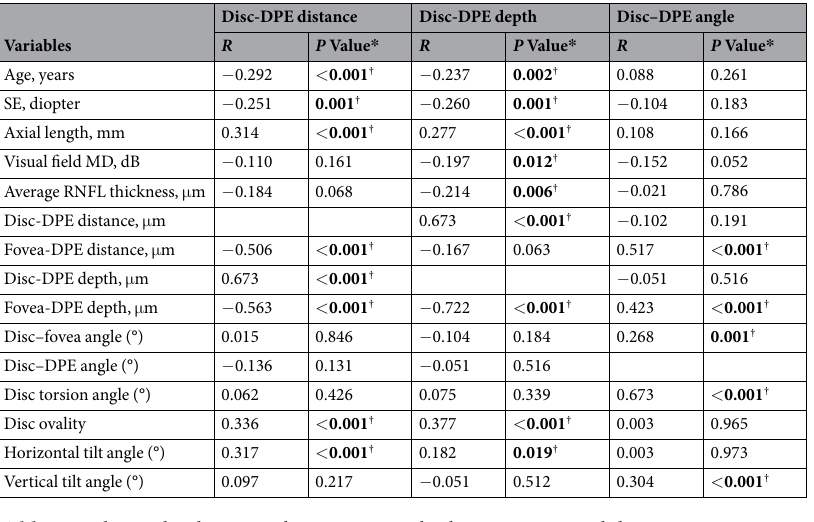
Table 5. Relationship between the posterior pole characteristics and the DPE in emmetropic and myopic eyes * . R = correlation coefficient; SE: spherical equivalent; MD: mean deviation of perimetry; RNFL: retinal nerve fiber layer; DPE: deepest point of the eyeball. * Pearson’s correlation analysis. † Statistically significant values ( P < 0.05) are shown in bold.